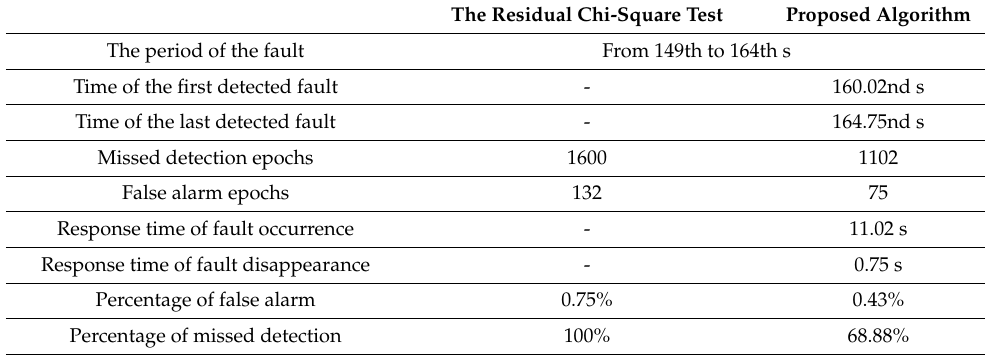
Table 3. The GNSS/INS integrated positioning performance of the EKF and the proposed algorithm.